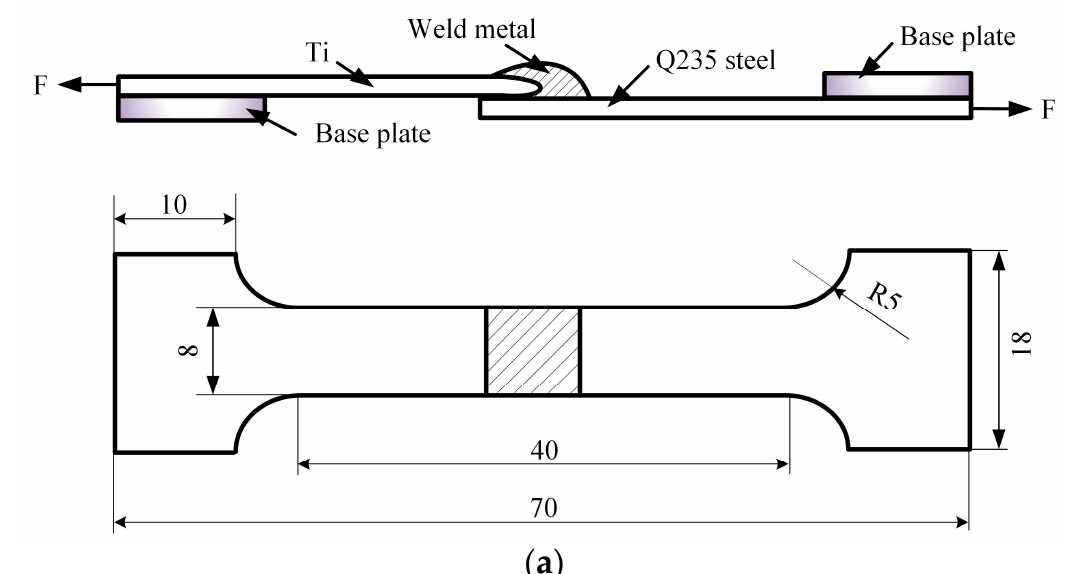
Figure 2. Dimensions (in mm) and configuration of cross-sections of the specimens: ( a ) Joint I (sample #1) and ( b ) Joint II (sample #2).